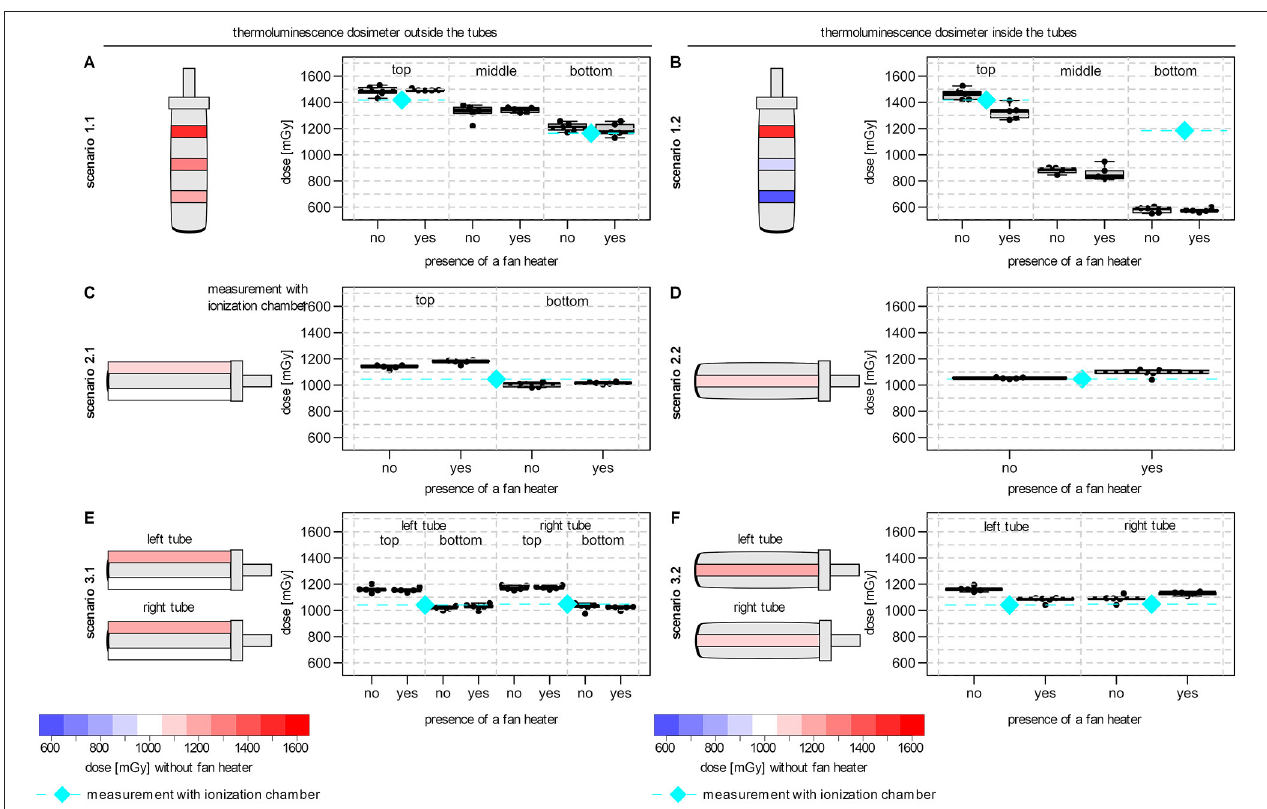
FIGURE 2 | Effects of experimental setup associated with dose gradients on TLD dose measurement. The schematic orientation of the tube is shown with a color-coded representation of the dose variation (blue to red: low to high dose) and the median TLD doses for each position. (A) TLD measurements in three rings outside the vertical tube (scenario 1.1). (B) TLD measurements at three different heights inside the vertical tube (scenario 1.2). (C) TLD measurements above and below a single horizontal tube (scenario 2.1). (D) TLD measurements within a single horizontal tube (scenario 2.2). (E) TLD measurements above and below two horizontal tubes (scenario 3.1). (F) TLD measurements inside two horizontal tubes (scenario 3.2). All tubes were filled with water for the dose measurements. Irradiation was performed in the center of the beam area and in presence or absence of an additional fan heater. The median dose of the ionization chamber for the comparable positions (without fan heater) were also shown (diamond with dashed line in cyan). Boxplots showing the median, lower and upper quartiles of the number of the measured dose in mGy. Whiskers were derived as described in the default “boxplot” function of the statistic software R (version